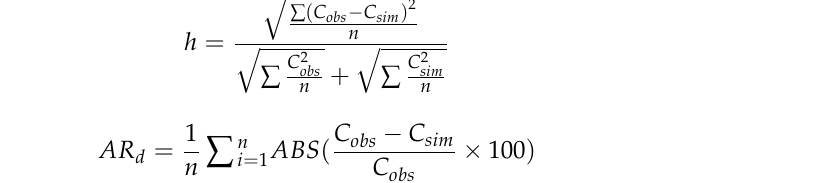
Table 2. Model setting of defined scenarios.